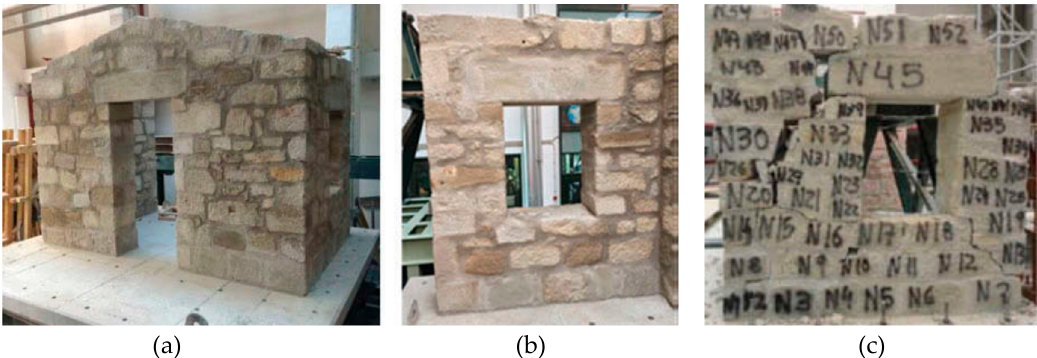
Figure 7. Stone structure: ( a ) general view and ( b ) return wall with opening; ( c ) damage of the return wall after the test (adapted from [23]).